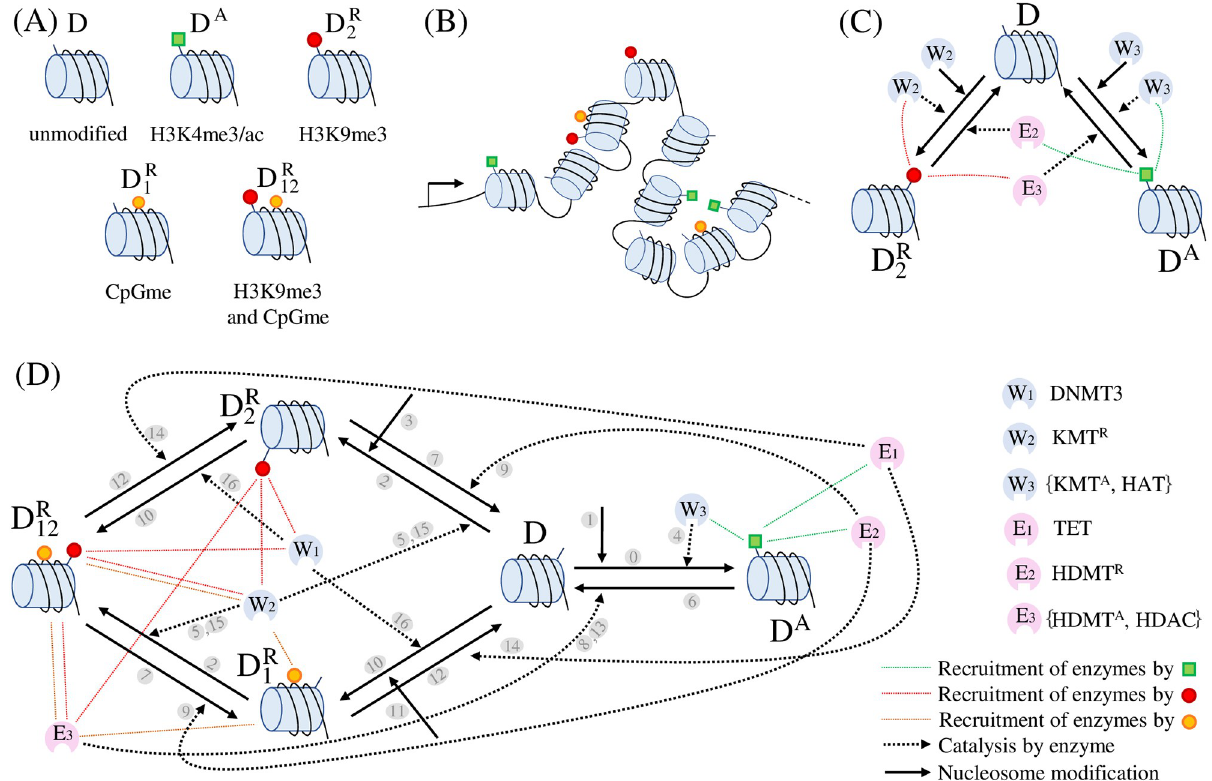
Fig 1. The gene’s inner chromatin modification circuit. (A) Nucleosome modifications: D (unmodified nucleosome), D A (nucleosome with a activating histone modification, H3K4me3/ac), D R (nucleosome with only DNA methylation, CpGme), D R (nucleosome with only a repressive histone 1 2 modification, H3K9me3) and D R (nucleosome with both H3K9me3 and CpGme). (B) Pictorial representation of a gene with its nucleosomes carrying 12 various modifications. The left side arrow represents the promoter. (C) Competitive interactions between opposing histone modifications (activating D A and repressive D R ), wherein each modification recruits writers of itself and erasers of the opposing modification. (D) Complete chromatin 2 modification circuit that includes all the interactions described in Section “Models” (see also Figs B and C in S1 File). The numbers shaded in gray on the arrows correspond to the reactions associated with the arrows, described in the main text and in Fig 2. In (C) and (D), enzymes that write (writers) and erase (erasers) each modification are represented as W 1 , W 2 , W 3 and E 1 , E 2 , E 3 , respectively. The socket on each enzyme represents a domain that binds to protein readers of the indicated (by the dashed lines) modification, enabling the process by which each modification recruits writers or erasers to nearby histones. To distinguish the KMTs for H3K9 and H3K4, we define the writers for H3K9 methylation (Suv39H1) as KMT R and the writers for H3K4 methylation (SETs and MLL1/2) as KMT A . Similarly, to distinguish the HDMTs for H3K9 methylation and H3K4 methylation, we define the erasers for H3K9 methylation (JMJD2A) as HDMT R and the erasers for H3K4 methylation (JARID) as HDMT A . We use colored dotted lines to depict the recruitment process by H3K4me3/ac (green lines), H3K9me3 (red lines), and CpGme (orange lines) and we use dotted black arrows to depict the consequent effect on writing/erasing. The solid black arrow represents the nucleosome